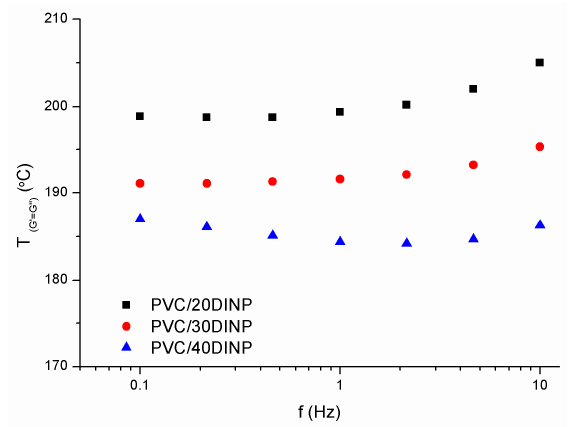
Figure 6. Values of the cross-over G ′ = G’’ temperature, T (G ′ = G ″ ) , as a function of the applied frequencies for the different samples.